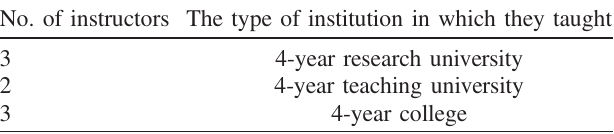
TABLE IX. The institutional affiliation of the focus group participants ( N ¼ 8